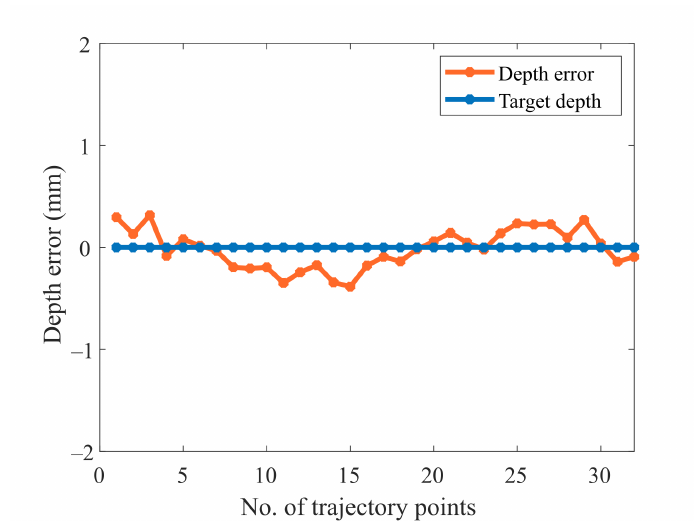
Figure 17. Absolute depth error while tracking the curved